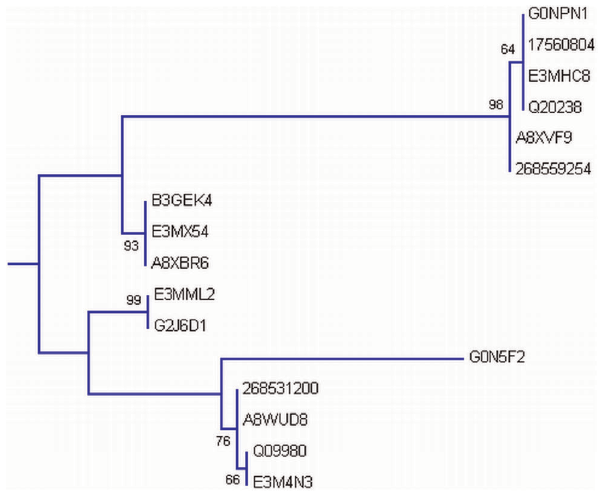
Figure 7. Group III. Tree showing all proteins included in this group.